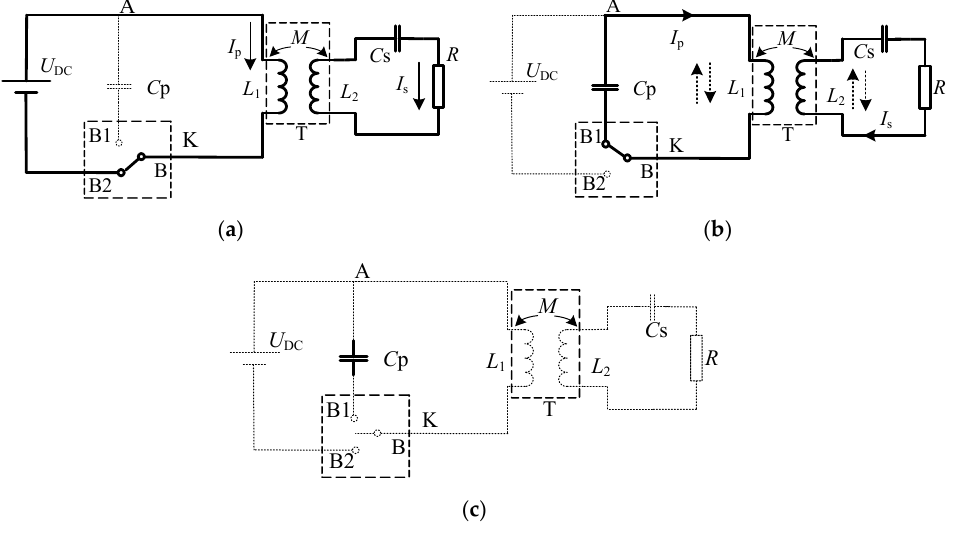
Figure 2. Schematic diagram of IIEIFR system. ( a ) Energy injection stage; ( b ) Free resonance stage; ( c ) Shutdown stage.